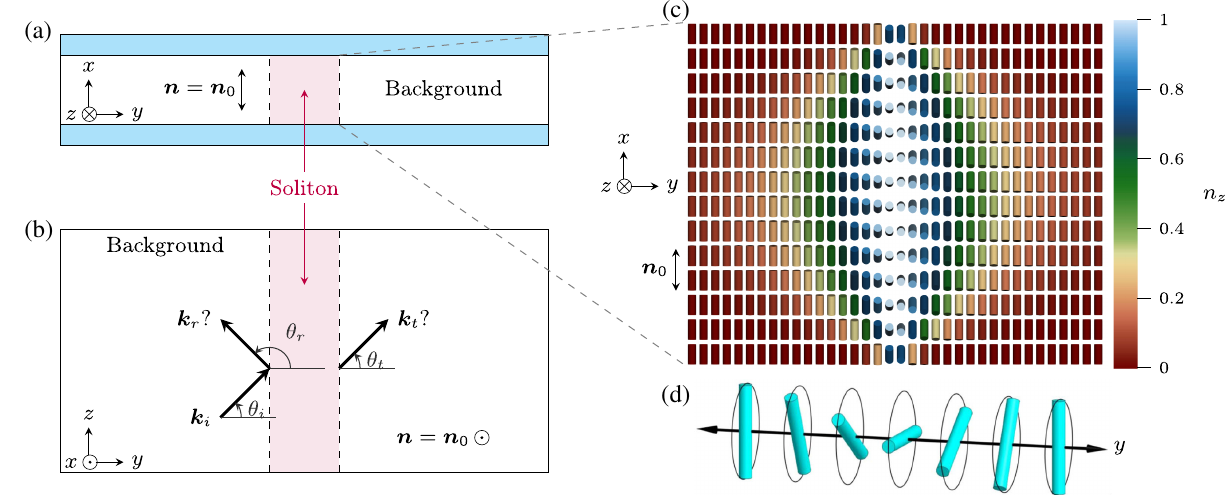
FIG. 3. Side (a) and top (b) view of the system, which consists of a LC layer confined between two plates in blue, with a topological soliton inside the LC layer along the z axis. A light beam with wave vector k is incident on the soliton in the yz plane and generates i reflected and transmitted beams. (c) Side view of the LC director field inside the simulated translationally invariant soliton. This soliton called a twist wall is invariant by translation along the z axis and represents the simplest type of translationally invariant soliton in frustrated cholesterics, with a π twist of the director field along the y axis represented schematically in (d). In (a) – (c), n 0 represents the orientation of the background director field far from the soliton. The projection of the translationally invariant director configuration ’ s components along the axis of invariance ( z axis) is indicated by the color scale in